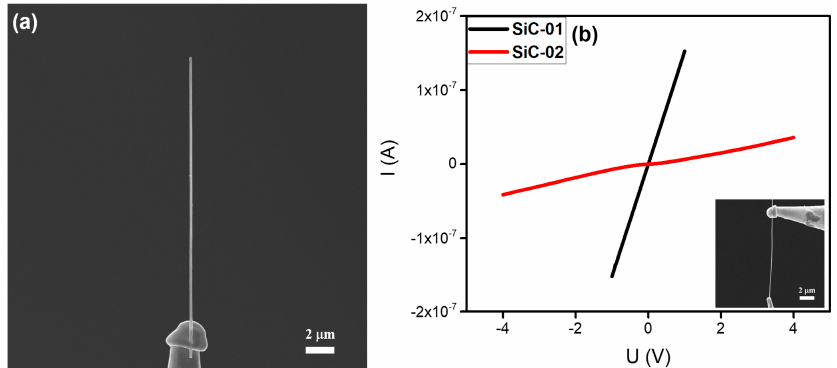
Figure 5. ( a ) SEM image of an individual SiC nanowire welded onto a tungsten needle. ( b ) Typical current versus voltage (I ‒ V curves) of two individual SiC nanowires. Typical SEM image of in-situ electrical measurement is given as an inset.